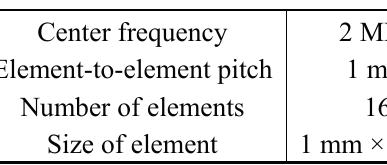
Table 1. Simulation parameters.